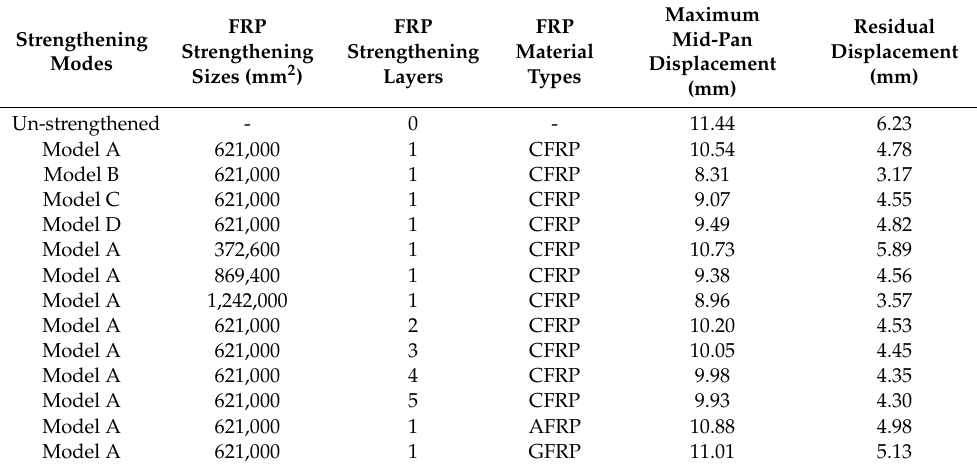
Table 4. Numerical results of strengthened beams with various parameters.